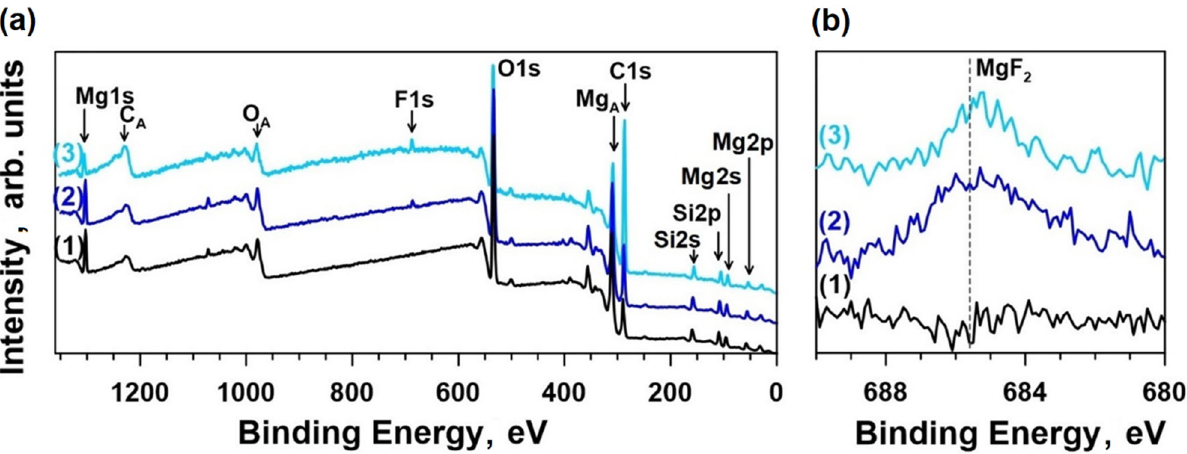
Figure 6. XPS spectra of PEO coatings: ( a ) survey spectrum; ( b ) specific spectrum of F 1s (1—Base, 2—F,